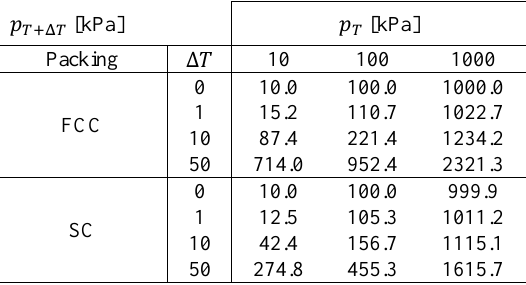
Table 3 . DEM 𝑝 𝑇+Δ𝑇 values for the regular packings.